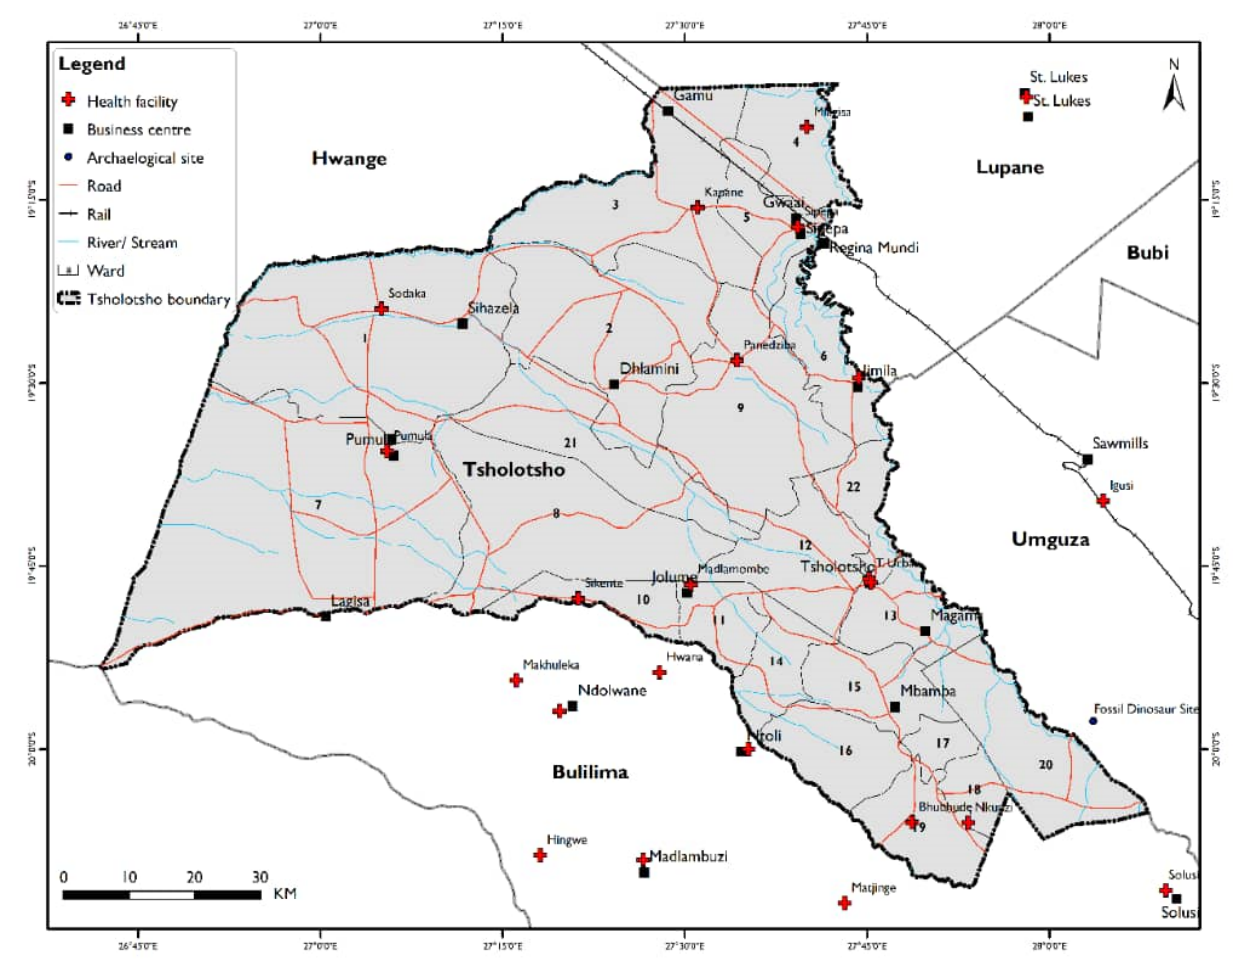
Figure 1. Tsholotsho District Map.